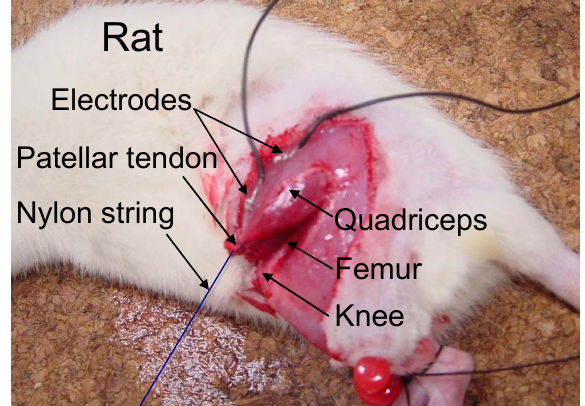
Fig. 2 Electrical stimulation to the rat quadriceps using needle-type electrodes. Muscle contraction force induced by the stimulation is transmitted to the force transducer through a nylon string tied with the patellar tendon, which is cut off from the patella, at the distal end of the